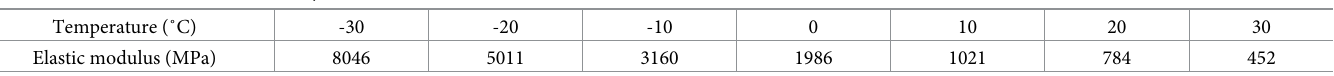
Table 7. Elastic moduli of the surface